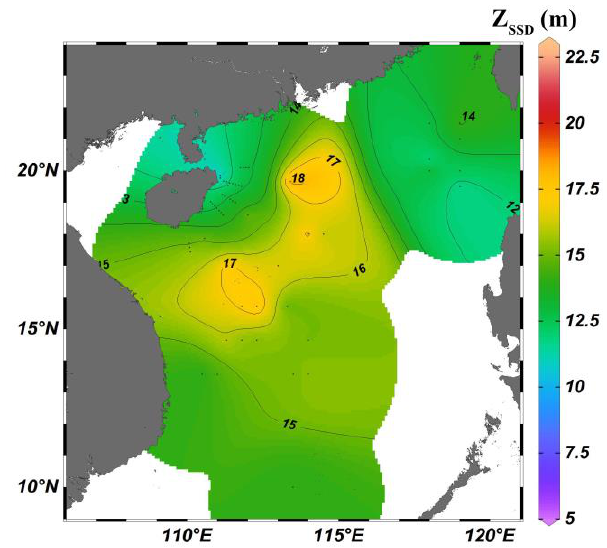
Figure 12. Spatial diagram of 𝑍 𝑆𝐷𝐷 in the investigation area.